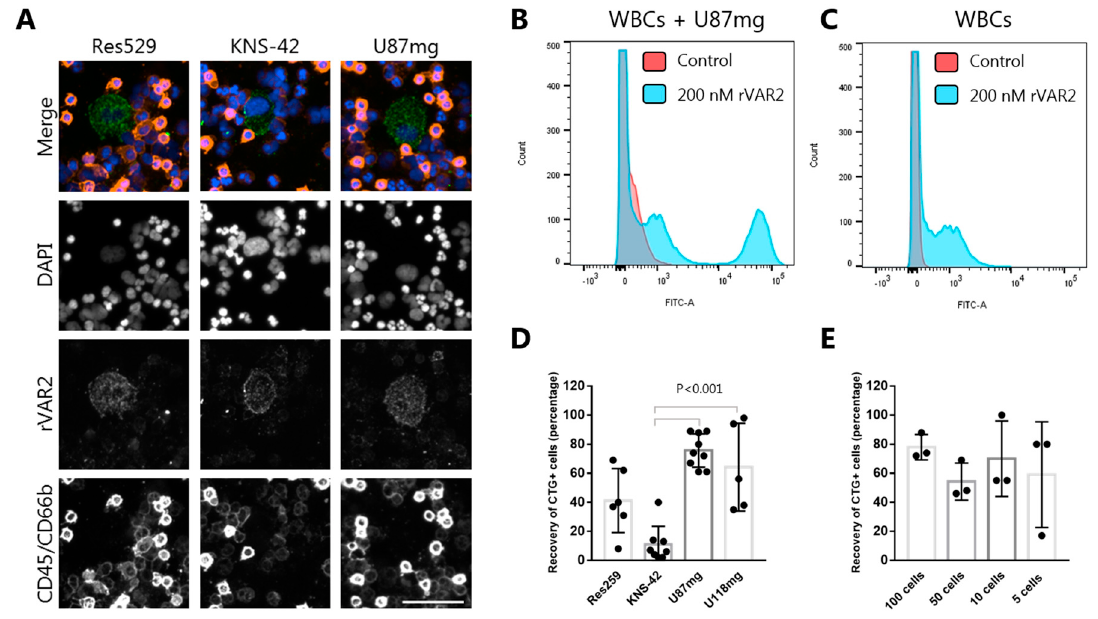
Figure 2. rVAR2 specifically binds to glioma cells and enables their retrieval from blood. ( A ) rVAR2 stains glioma cell lines in a background of white blood cells (WBCs). Res529 (left), KNS-42 (middle) and U87mg (right) cells were mixed with WBCs and stained with V5-tagged rVAR2 in combination with a CF488-conjugated anti-V5 antibody (green), PE-conjugated anti-CD45 and anti-CD66b antibodies (red), and DAPI (blue). Scale bar, 50 µ m. ( B ) Flow cytometry analysis showing WBCs (100 µ L RBC lysed blood) mixed with U87mg (50,000) cells and detected with either 200 nM rVAR2 and a FITC-conjugated anti-V5 antibody or with a FITC-conjugated anti-V5 antibody alone (control). ( C ) Same as in ( B ) but with no U87mg cells added. ( D ) Recovery of CellTracker Green-stained glioma cells from blood. 100 cells were spiked into 3 mL blood and recovered using rVAR2-coupled beads. Cells were stained with DAPI and scanned on the Cytation 3 Imager. Each dot represents the percentage of recovered cells from one sample. Bars represent mean recoveries and error bars show +/ − standard deviation (n ≥ 2) (one-way ANOVA with Bonferroni correction). ( E ) Recovery of CellTracker Green-stained U87mg cells from blood. The indicated number of U87mg cells was spiked into 3 mL blood and captured using rVAR2-coupled beads. Enumeration of cells and data presentation were done as in ( D ).